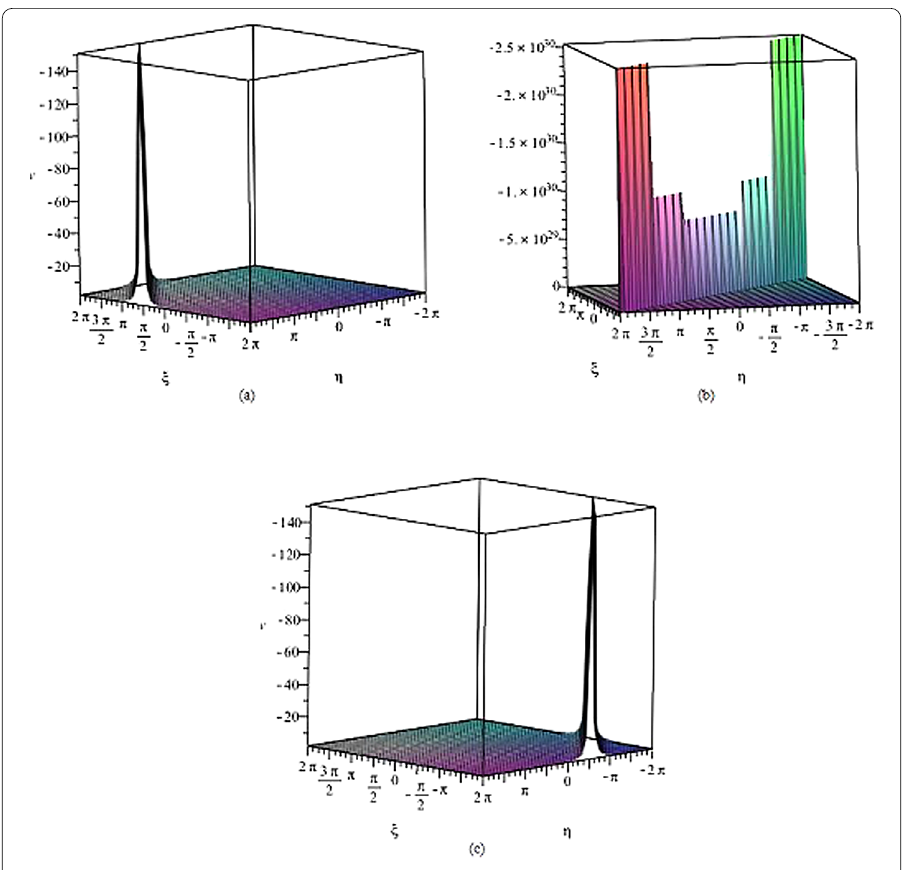
Figure 2 The solution of the YSTF equation corresponding to W s ( z ). (a) z 0 = –8, (b) z 0 = 0, (c) z 0 =